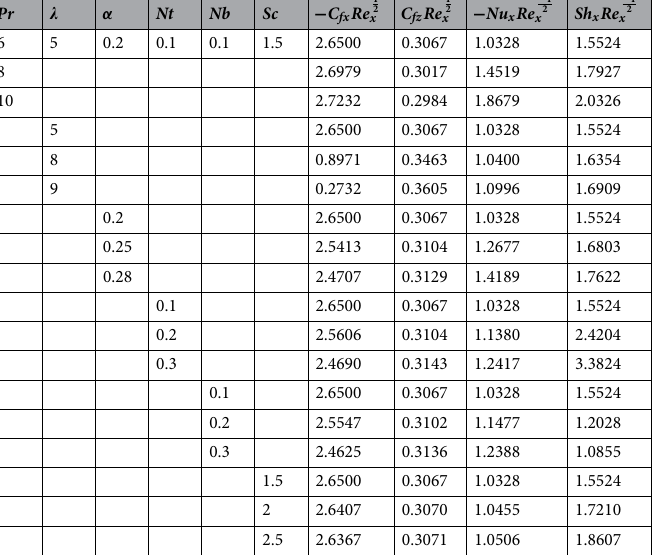
Table 2. Numerical values of skin friction coefficients